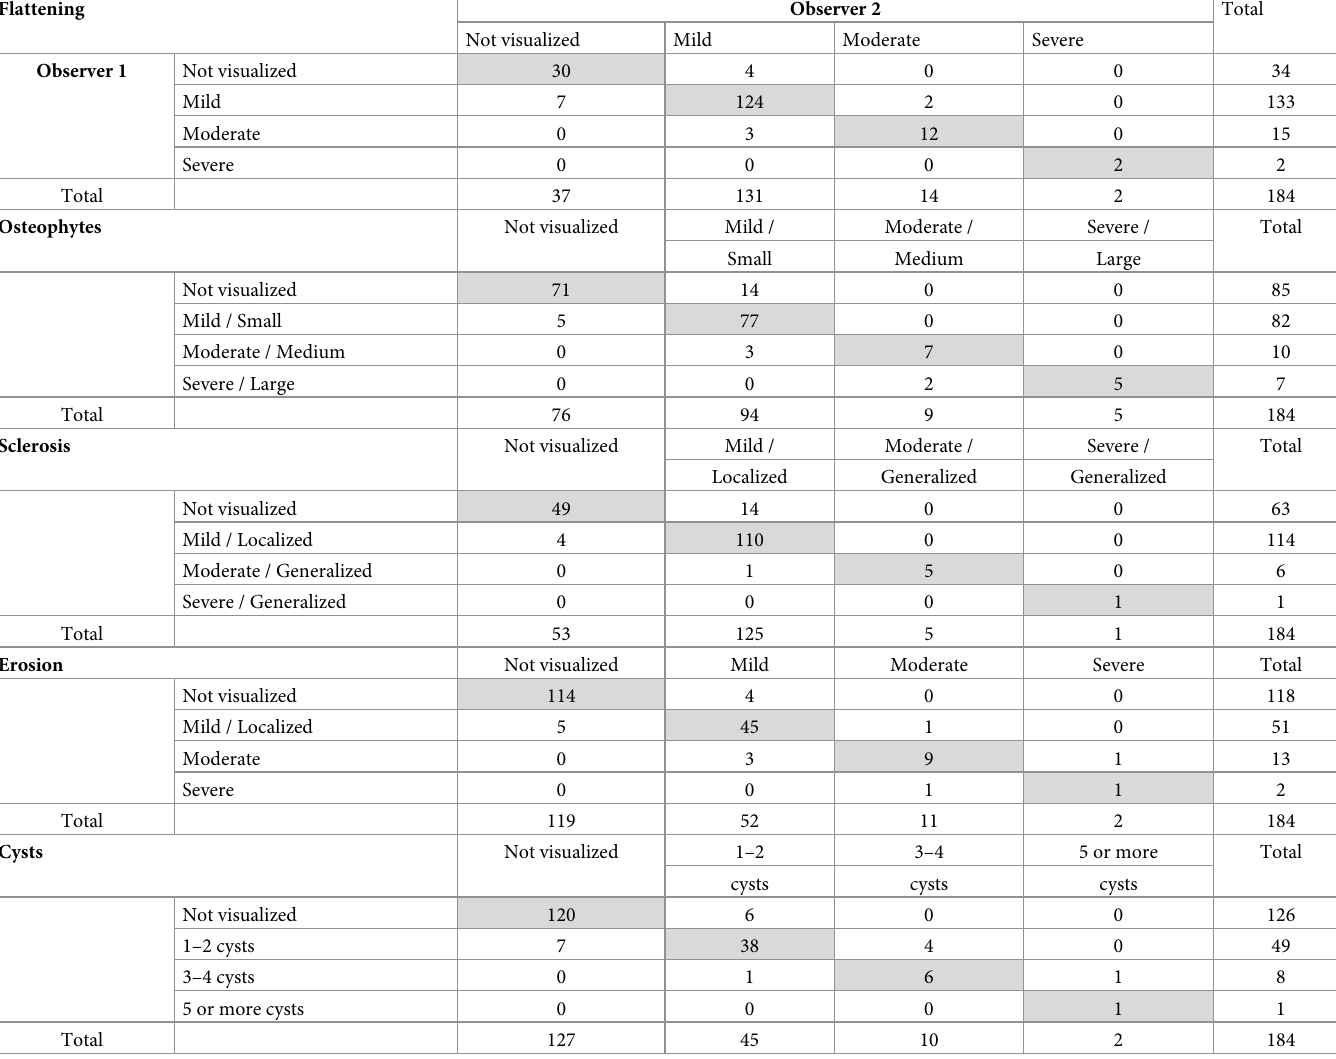
Table 1. Agreement matrix of the radiologists (observer 1 and 2) for each radiographic finding visualized in a multi-planar HR-CBCT evaluation for both groups together. The agreement is shown in diagonal. The numbers represent the total number of mandibular condyles in their specific category.